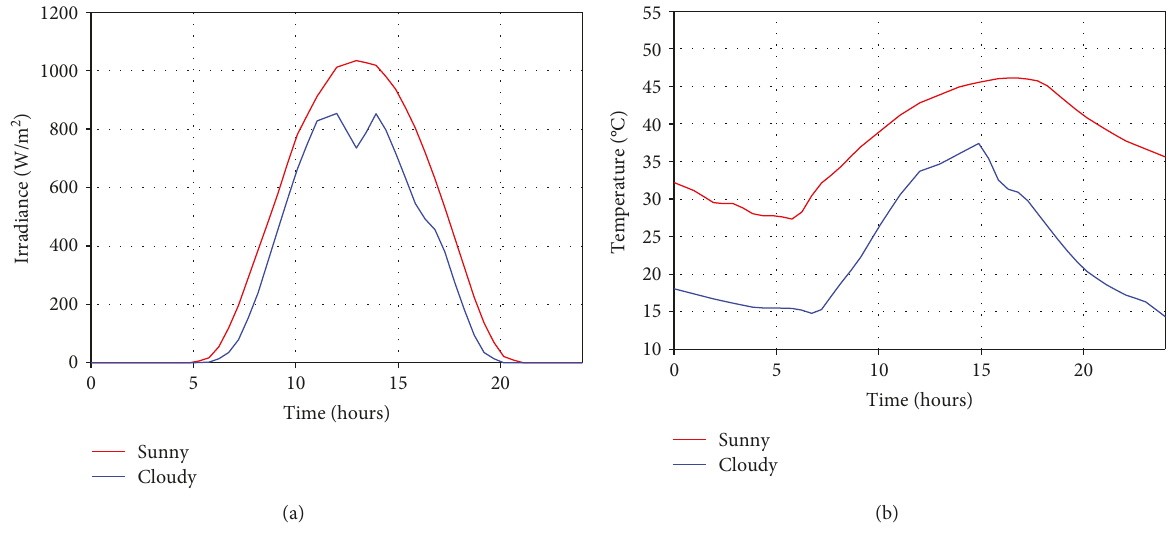
Figure 14: Daily climate condition of a sunny (a) day and a cloudy (b)